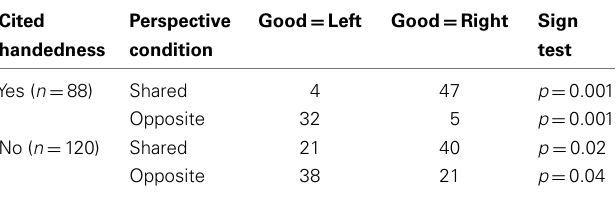
Table 1 | Judgments from participants who did and did not mention handedness when justifying their responses in Experiment